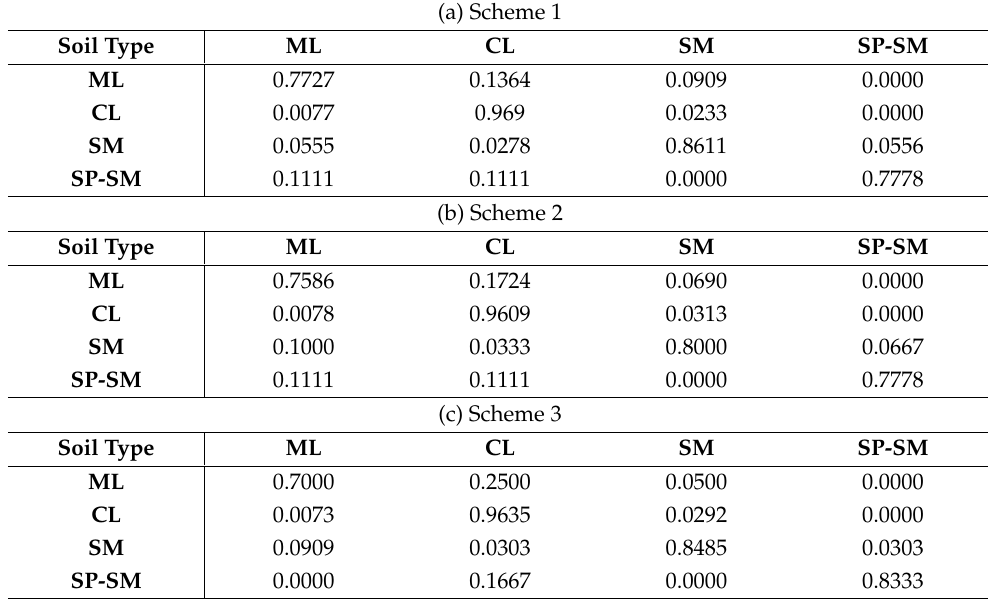
Table 3. The estimated VTPMs for various borehole schemes.